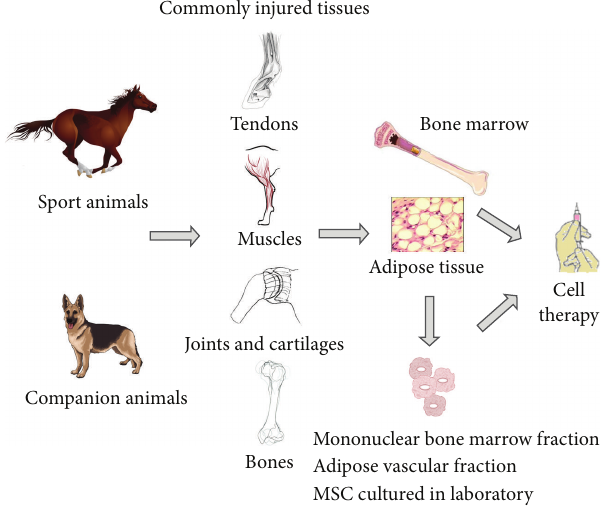
Figure 2: Cell therapy applications in veterinary medicine. Com- panion animals (pets), due to genetic factors, degenerative pro- cesses, and inadequate diet, and animals used in sports, such as running and jumping, are subject to several kinds of injuries, which may affect primarily the muscle tissue, causing pain, cartilage wear in joints and spinal disks, tendonitis, fractures, and bone degeneration. Clinical applications and protocols are based on the use of adult stem cells, isolated from fresh bone marrow or adipose tissue, or expanded from these tissues in laboratory. The derived cells, mesenchymal stem cell (MSC), have a high therapeutic